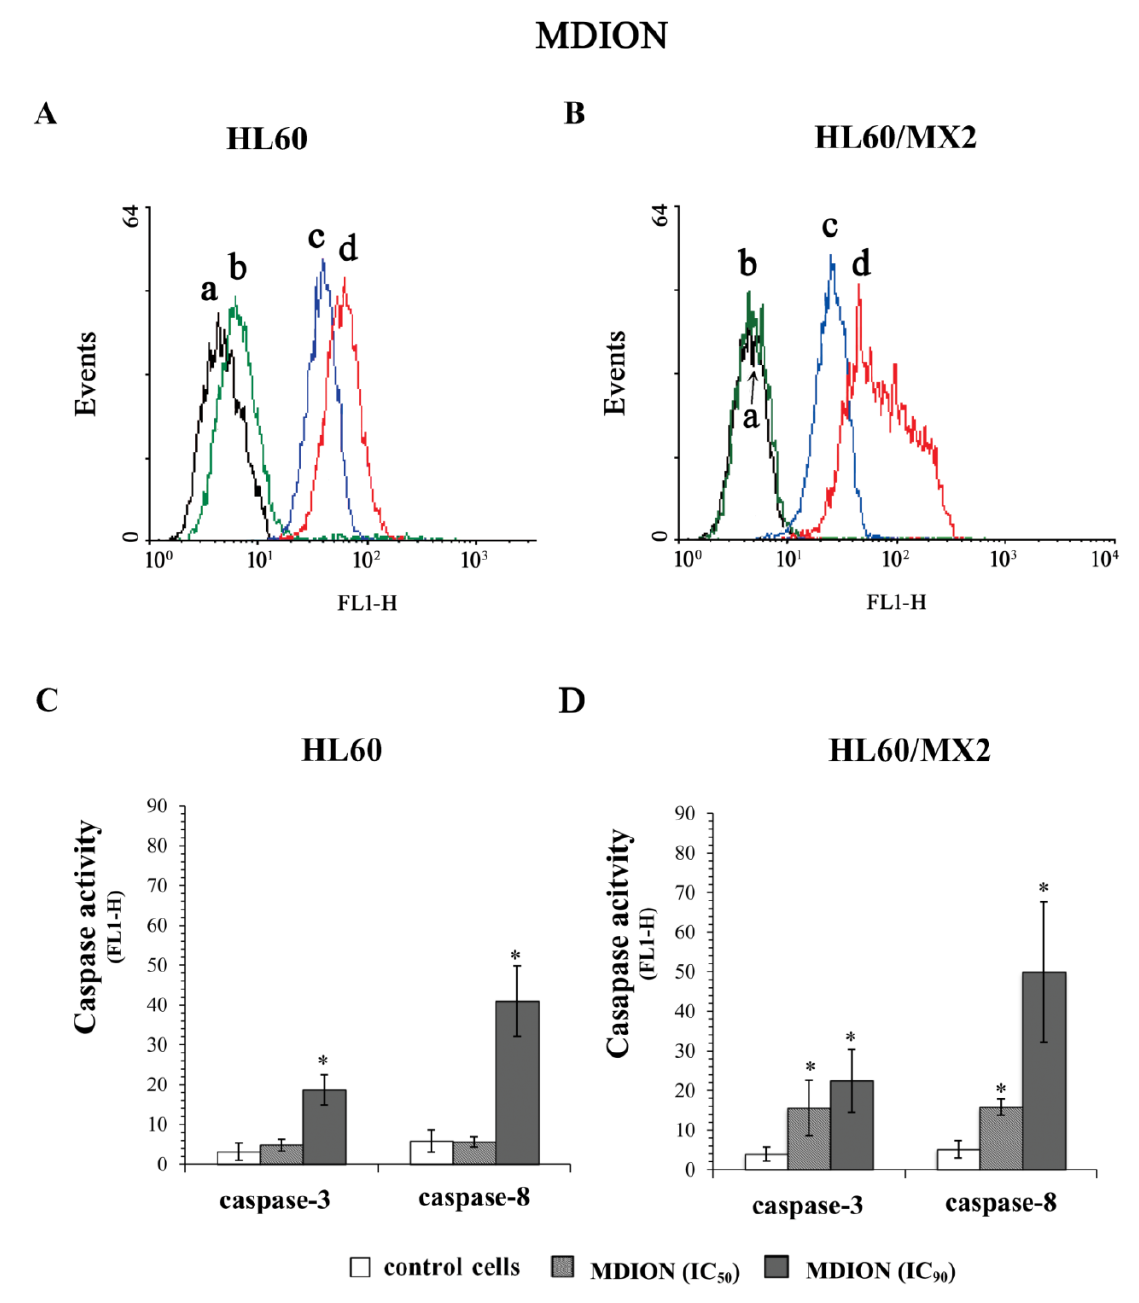
Figure 9. Caspase-3 and caspase-8 activity in sensitive HL60 ( A , C ) and resistant HL60/MX2 ( B , D ) leukaemia cells treated with MDION. The cells were incubated at 37 ◦ C with MDION used at IC 50 (80.5 µ M for HL60 cells and 95.5 µ M for HL60/MX2 cells) or at IC 90 (573.0 µ M for HL60 cells and 591.2 µ M for HL60/MX2 cells), respectively, for 72 h. The activity of caspases was determined using specific membrane-permanent, fluorescent inhibitor-based FLICA caspase probes (FITC-DEVD-FMK for caspase-3 and FITC-IETD-FMK for caspase-8, respectively). Presented histograms ( A , B ) are representative examples observed for control and treated cell samples (a, black—caspase-3 in control cells; b, green—caspase-8 in control cells; c, blue—caspase-3 in cells treated with MDION at IC 90 ; and d, red—caspase-8 in cells treated with MDION at IC 90 ). The experiment was repeated at least three times (made in duplicate) and the data are given as the mean ± SD values ( C , D ). The significance level of the differences observed (Student’s t -test) between values found for cells treated with MDION at IC 50 or IC 90 , respectively, (* p < 0.05) compared with values found for control